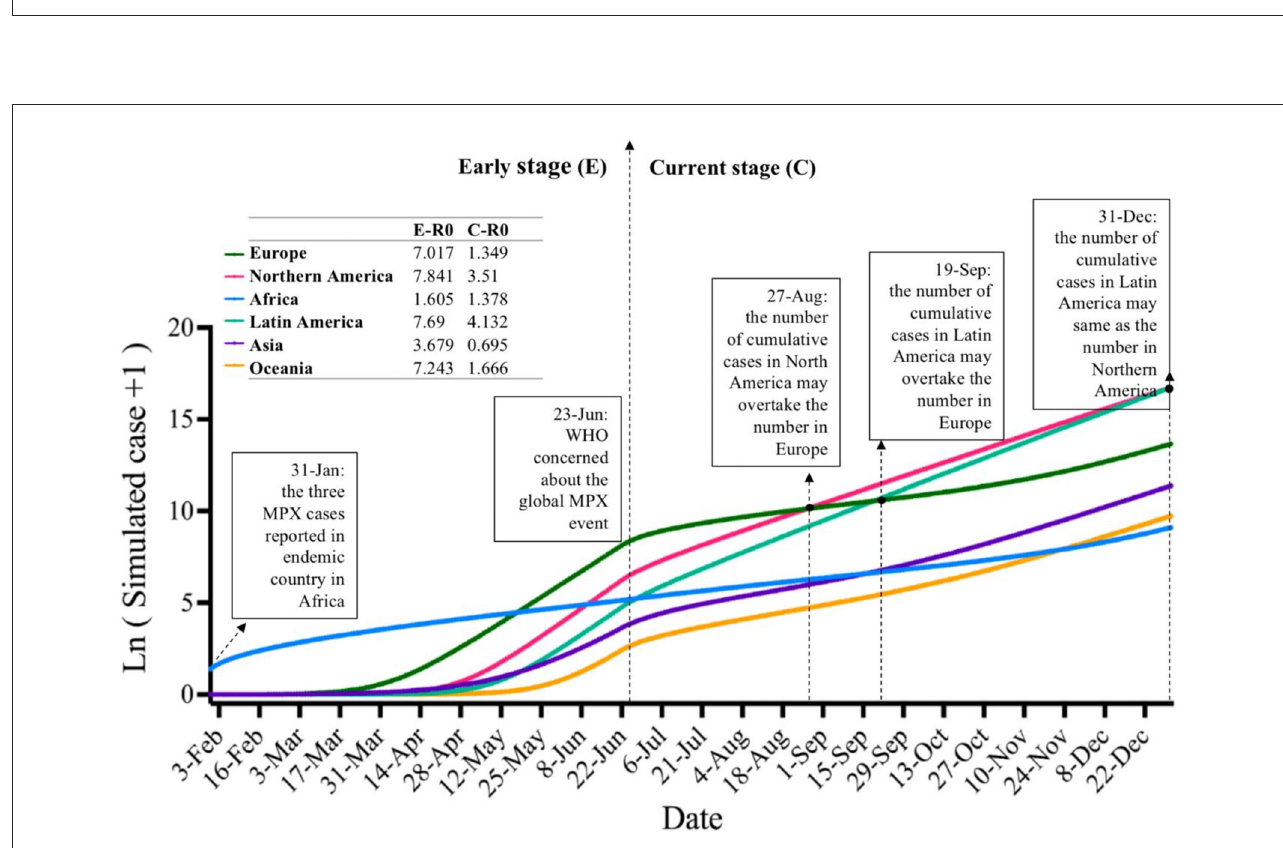
FIGURE3 Simulated cumulative MPX cases on six continents predicted by a modified SEIR model. SEIR, susceptible-exposed-infectious-removed; MPX, monkeypox